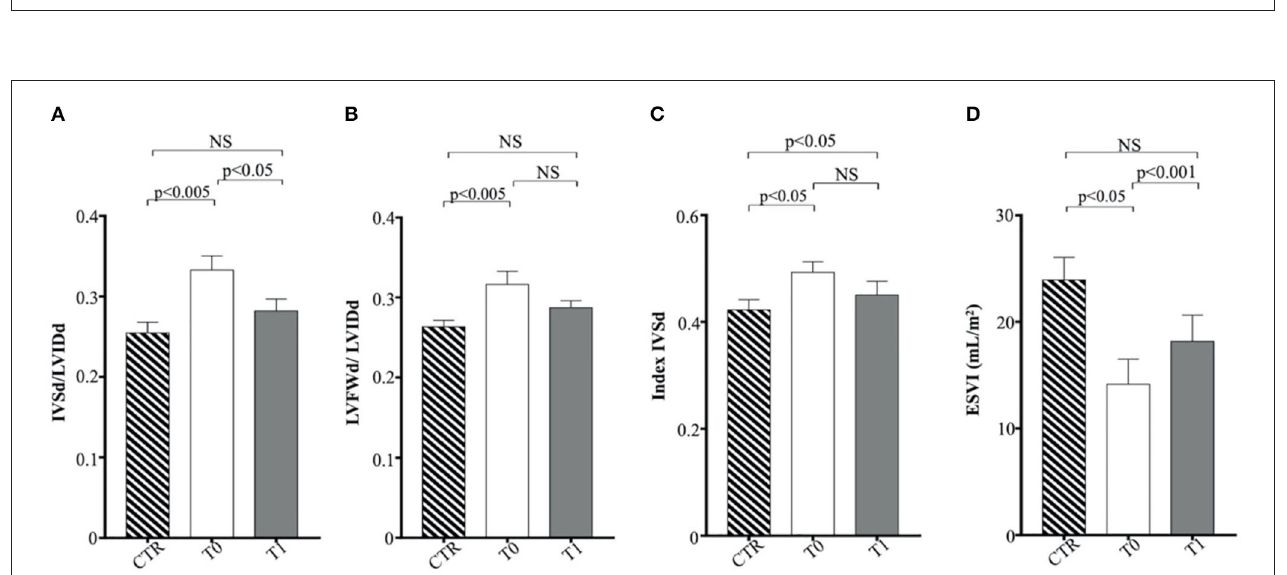
FIGURE 4 | Echocardiographic parameters in enrolled dogs. (A) IVSd, interventricular septum at end diastole; (B) LVFWd, left ventricle free wall at end diastole. Obese dogs at T0, white column; obese dogs at T1, gray column. Statistics: Wilcoxon matched-pairs signed-rank test was used for T0 and T1 comparation in obese dogs. NS means not significant difference.